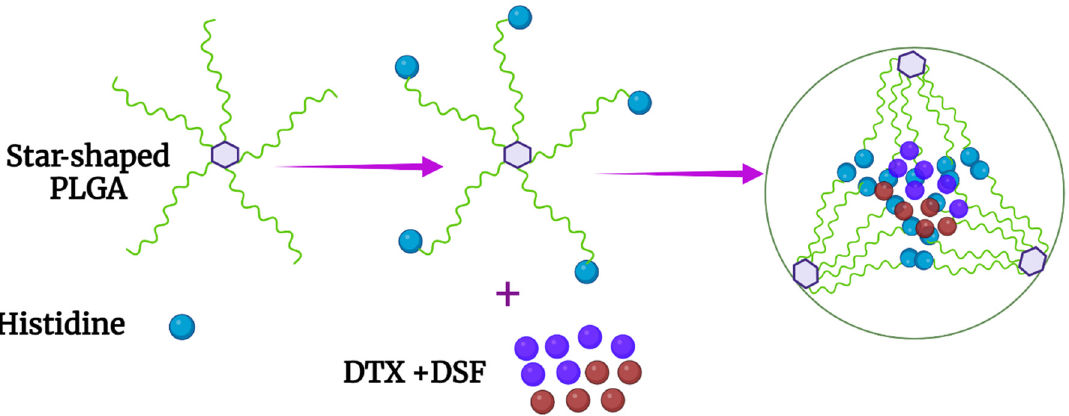
Figure 7. Schematic of the five-armed star-shaped polymer in which PLGA-His forms the inner shell. The hydrophobic drugs docetaxel and disulfiram, which have demonstrated antitumor synergy, were entrapped within the interior of the micelle.